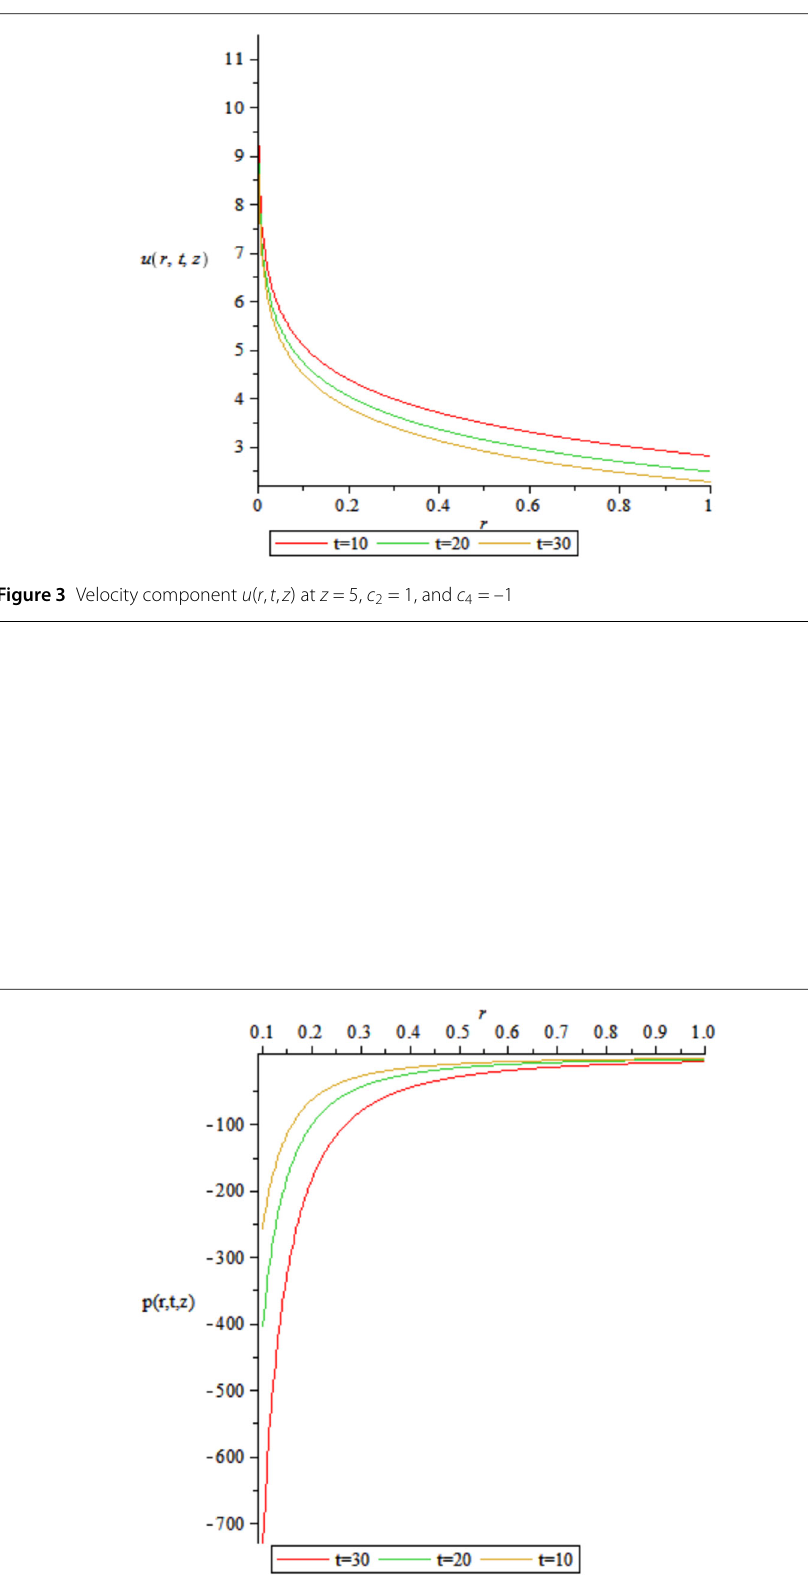
Figure 4 The pressure p ( r , t , z ) at z = 5, c 1 = 1, c 2 = 1, c 3 = 1, and c 4 =